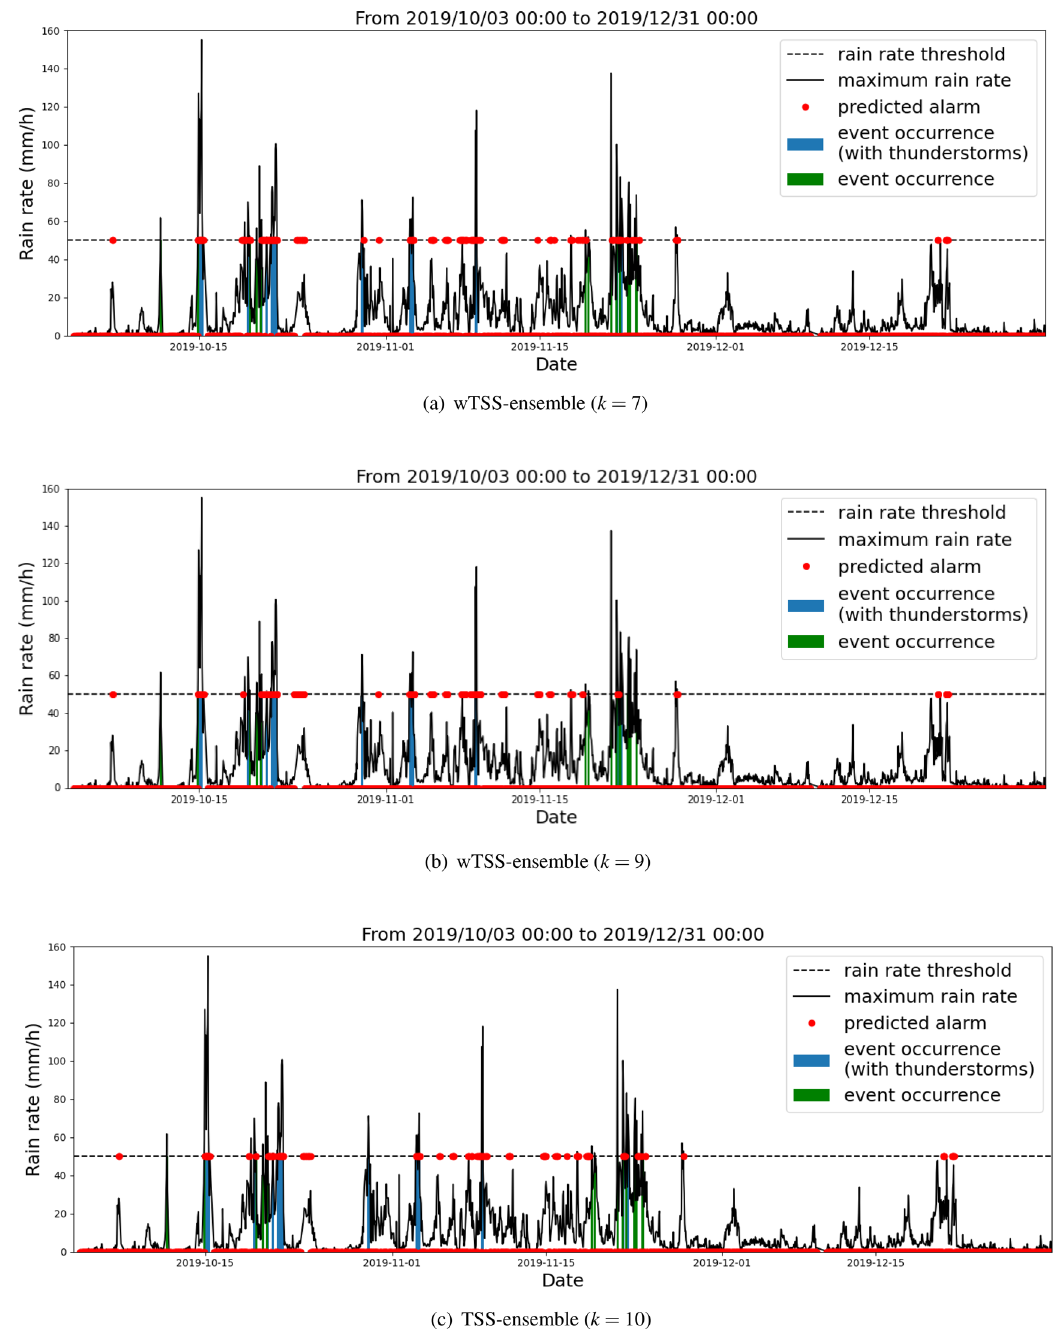
Figure 8. Predictions for the testing period obtained by applying the wTSS-ensemble strategy at k = 7 run (top panel), the wTSS-ensemble strategy at k = 9 run (central panel) and the TSS-ensemble strategy at k = 10 run (bottom